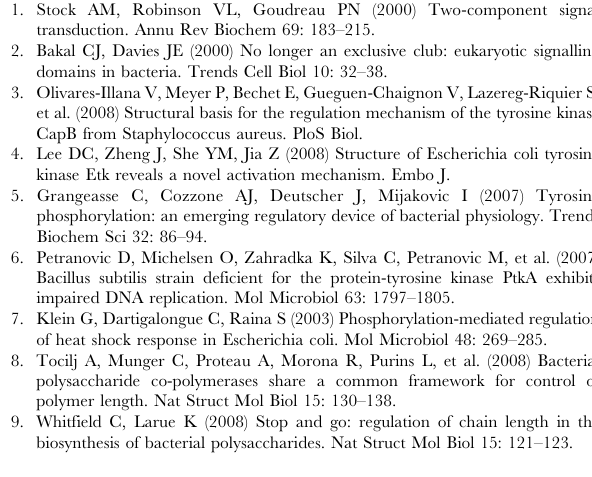
Table S1 Bacterial strains and plasmids used in this study DOC) Table S2 Primers used in this